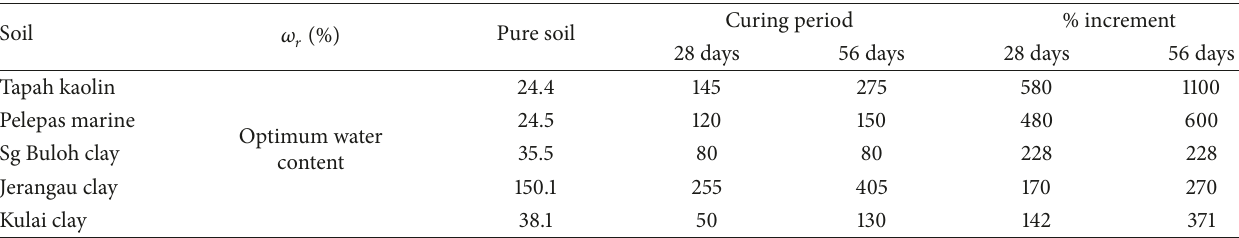
Table 5: UCS (kN/m 2 ) value from Kassim and Chem [10] study. Soil Pure